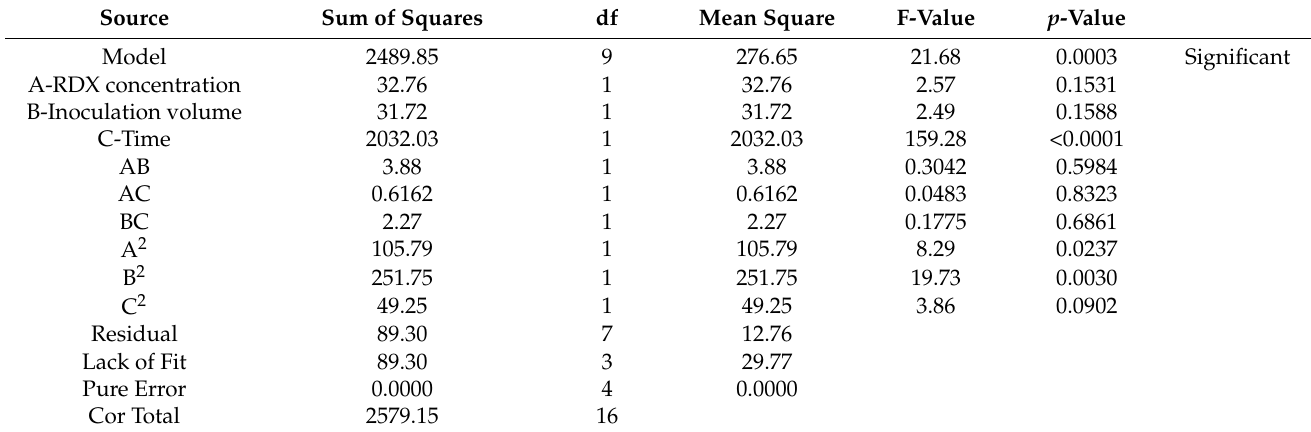
Table 3. ANOVA of Quadratic model for percent degradation of RDX with Paenibacillus dendritiformis . Source Sum of Squares df Mean Square F-Value p -Value